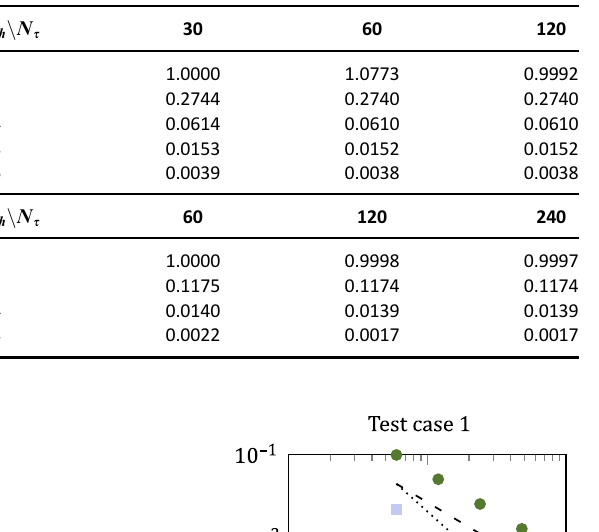
Table 6. (Time space convergence of lift with volume forcing, cf. section Convergence tests ) The approximation error e p 1 scaled hNh ; s N s by the inverse of e p 1 ¼ 1 : 29 (cid:4) 10 (cid:3) 4 for linear ansatz functions h 6 ; s 30 (top) and e p 1 scaled by the inverse of e p 2 ¼ 7 : 234 (cid:4) 10 (cid:3) 6 for hNh ; s N s h 6 ; s 60 quadratic ansatz functions (bottom) with ρ ref explicitly given for varying space and time discretizations for Test Case 2.